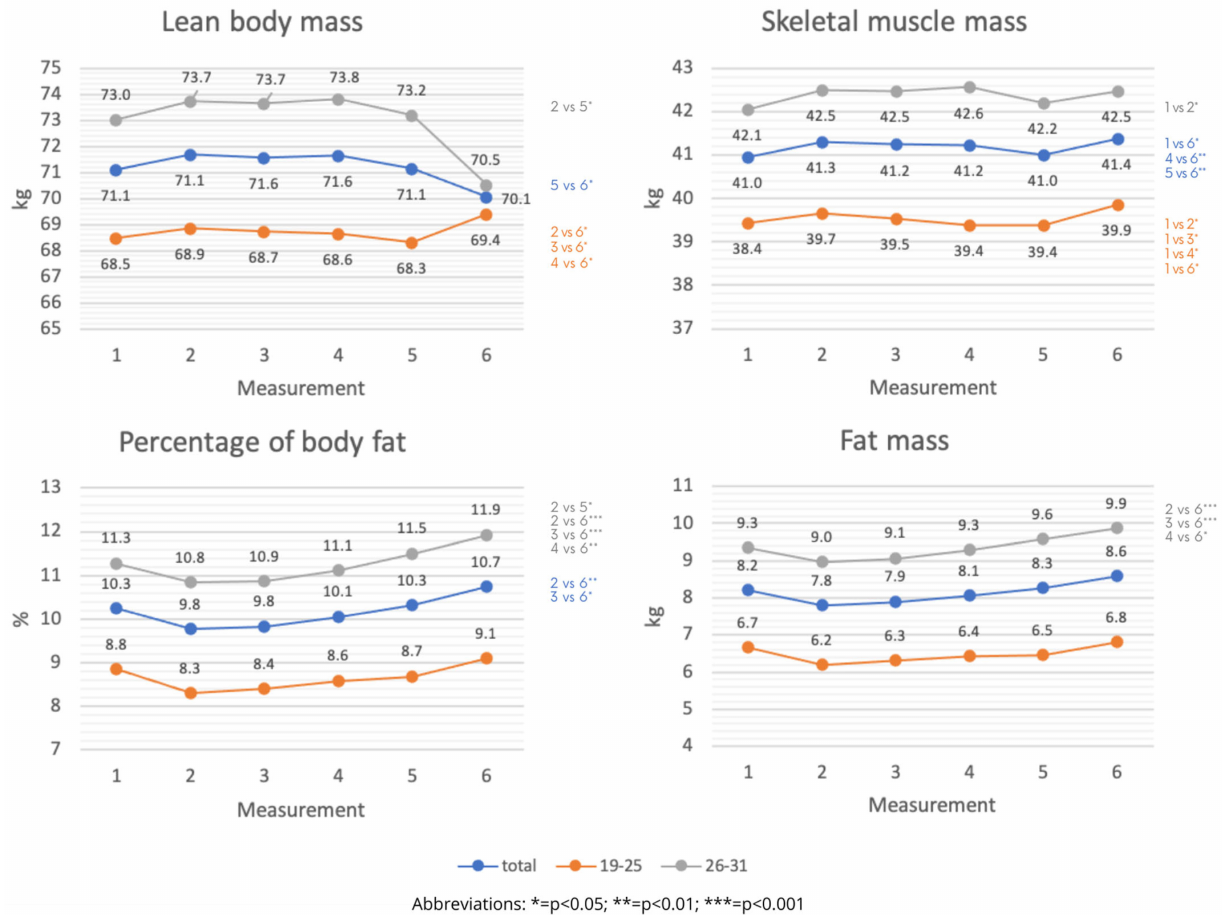
Figure 4. Changes in body composition of participants during the training macrocycle by age category (average